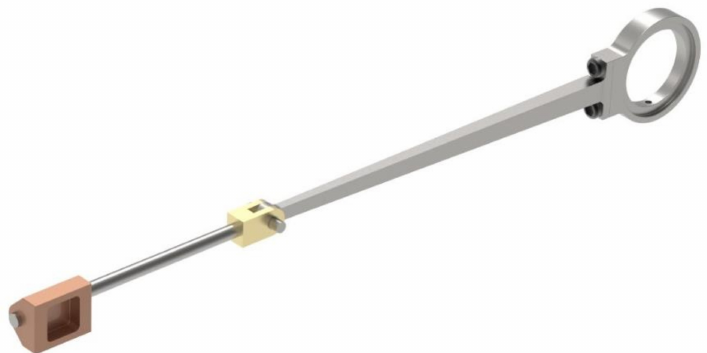
Figure 11. Slide valve subassembly.